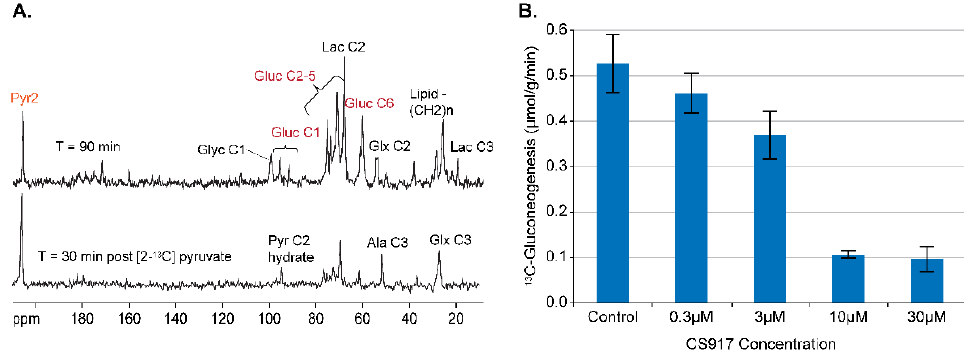
Figure 7. Development of an assay of GNG in db/db mouse liver. ( A ) 13 C NMR spectra 30 and 90 min after the administration of 10 mM [2- 13 C] pyruvate, illustrating the metabolism of [2- 13 C] pyruvate to 13 C-glucose, along with other metabolites. ( B ) The dose titration of the F-1,6-BPase inhibitor CS-917, a known inhibitor of GNG.